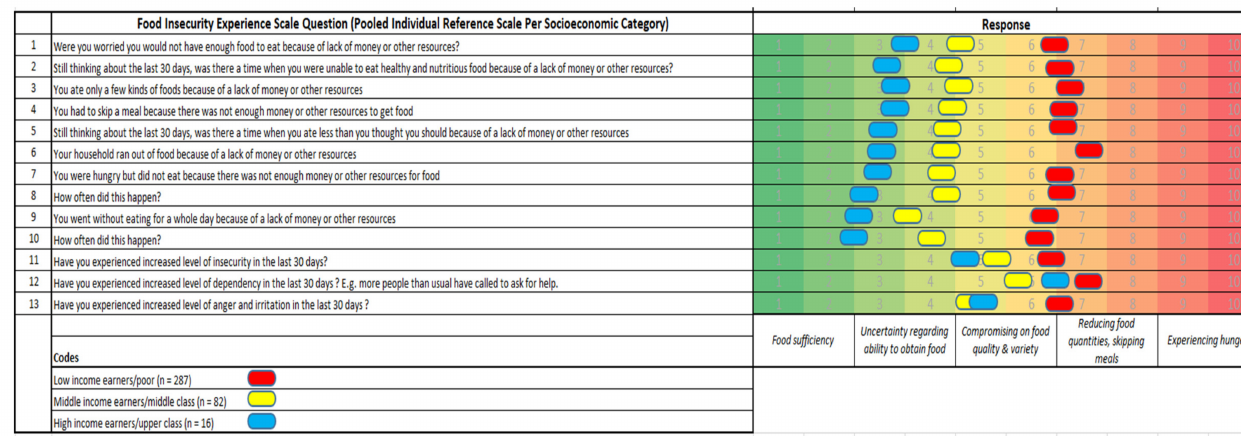
Figure 2. Modified food insecurity experience scale (FIES) pooled per socio-economic category during the 2020–2021 COVID-19 pandemic, Nigeria.